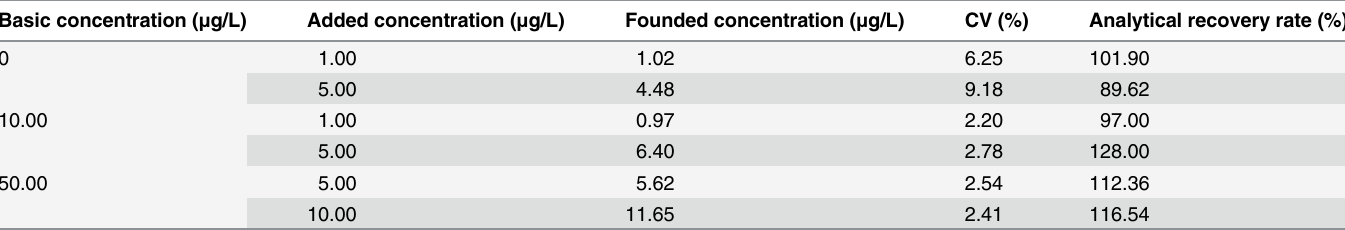
Table 5. Analytical recovery rate of determination of HBsAg in human serum (n = 10). Basic concentration ( μ g/L)